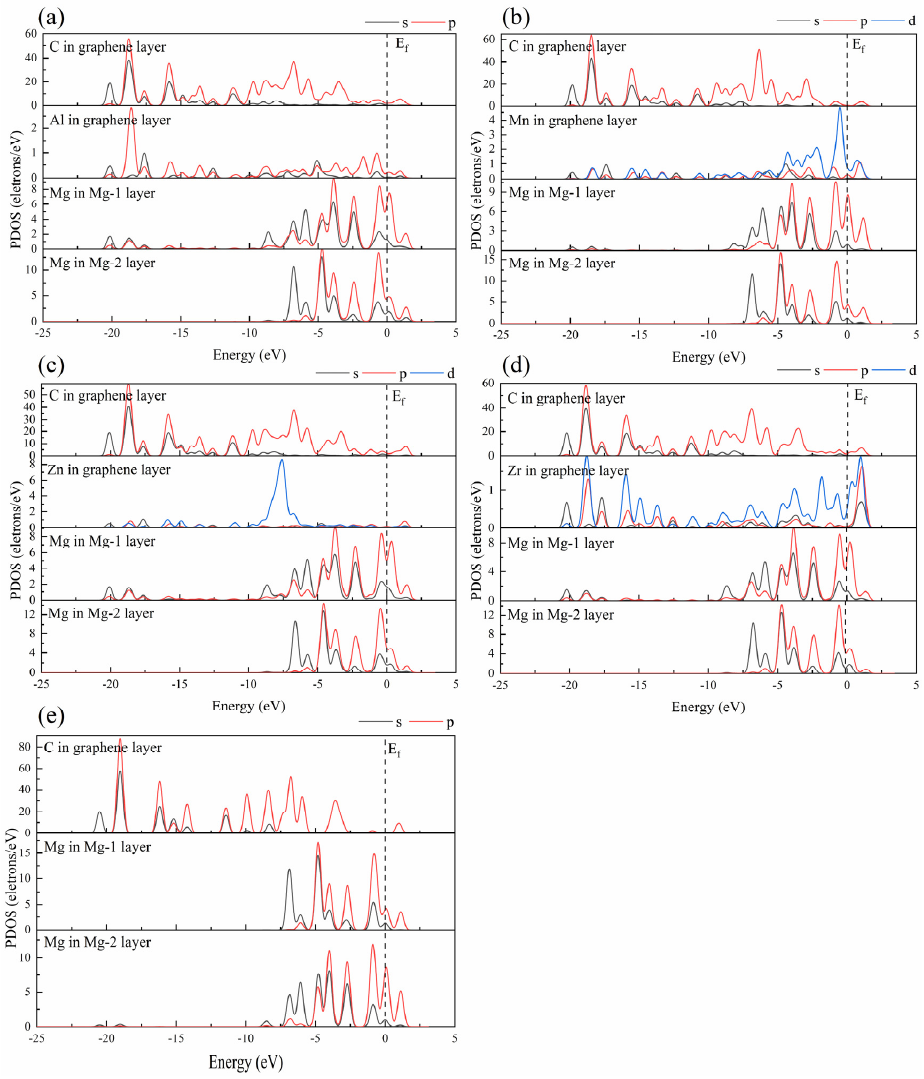
Figure 9. The partial density of the state of five interface models: ( a ) Al-doped interface, ( b ) Mn-doped interface, ( c ) Zn-doped interface, ( d ) Zr-doped interface, ( e ) intrinsic interface.